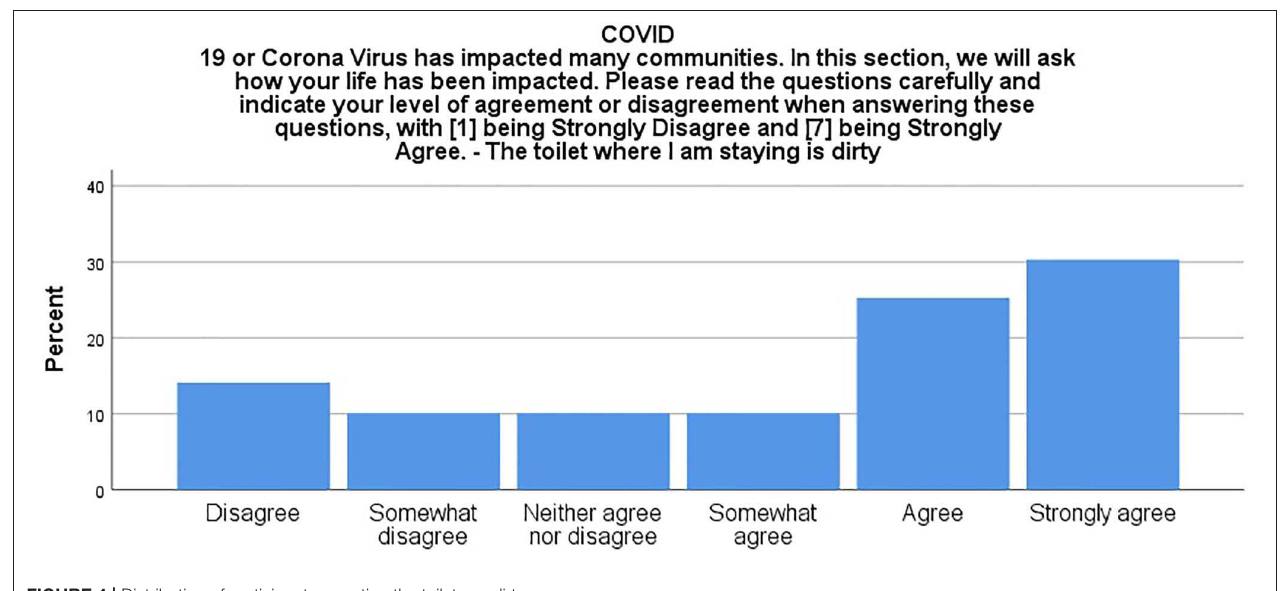
FIGURE 4 | Distribution of participants reporting the toilets as dirty.